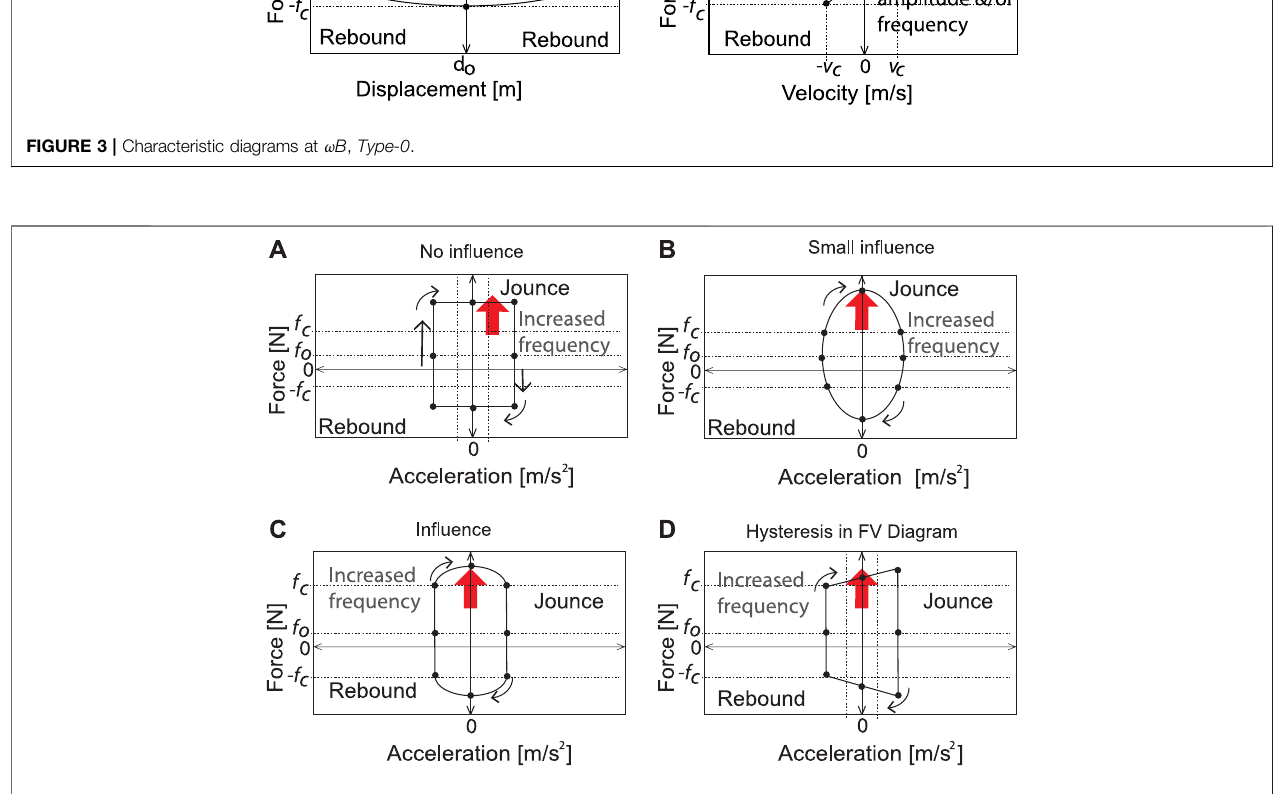
FIGURE 4 | Types of FA characteristic